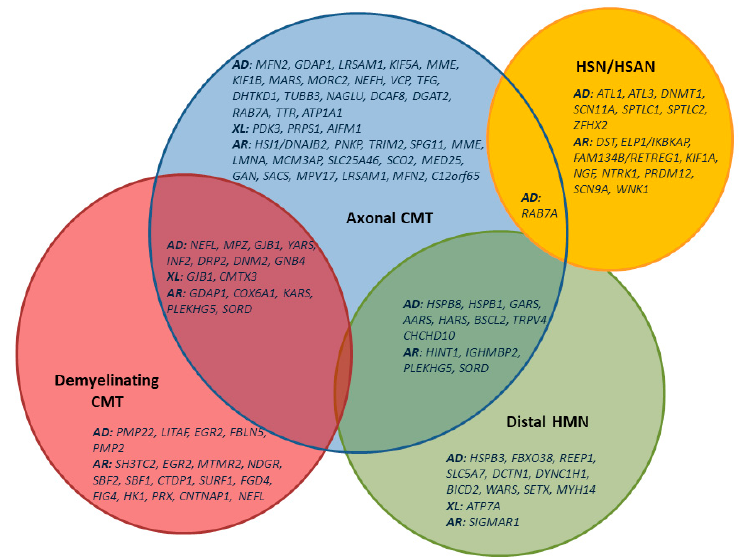
Figure 1. VENN diagram showing the distribution of mutations among clinical and electrophysio ‐ logical groups of hereditary neuropathies (CMT/HSAN/dHMN) [8].